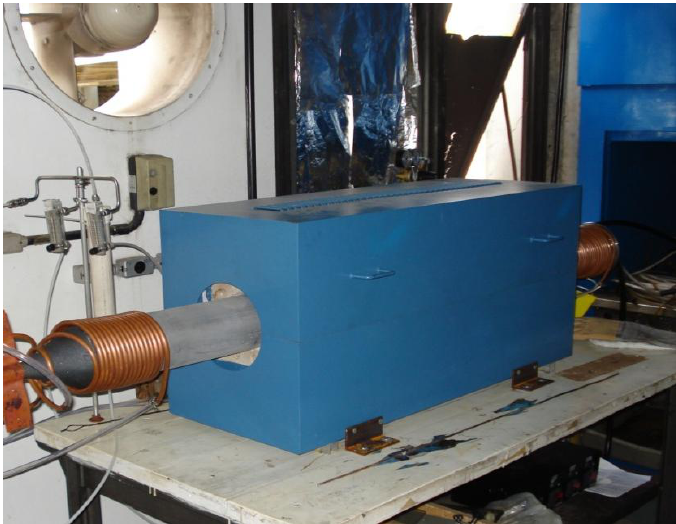
Figure 1. The CVD reactor used for in situ CNT/CNF synthesis on cementitious